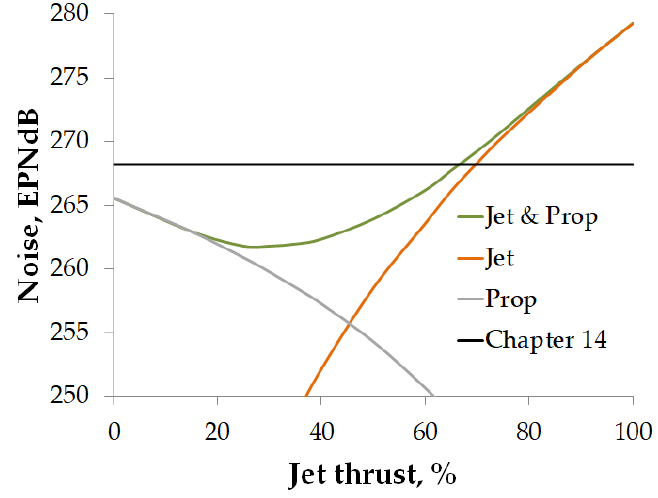
Figure 5. Cumulative noise levels for the supersonic aircraft with turboprop engines for different ratios of thrust produced by turbofan engines and turboprop engines.